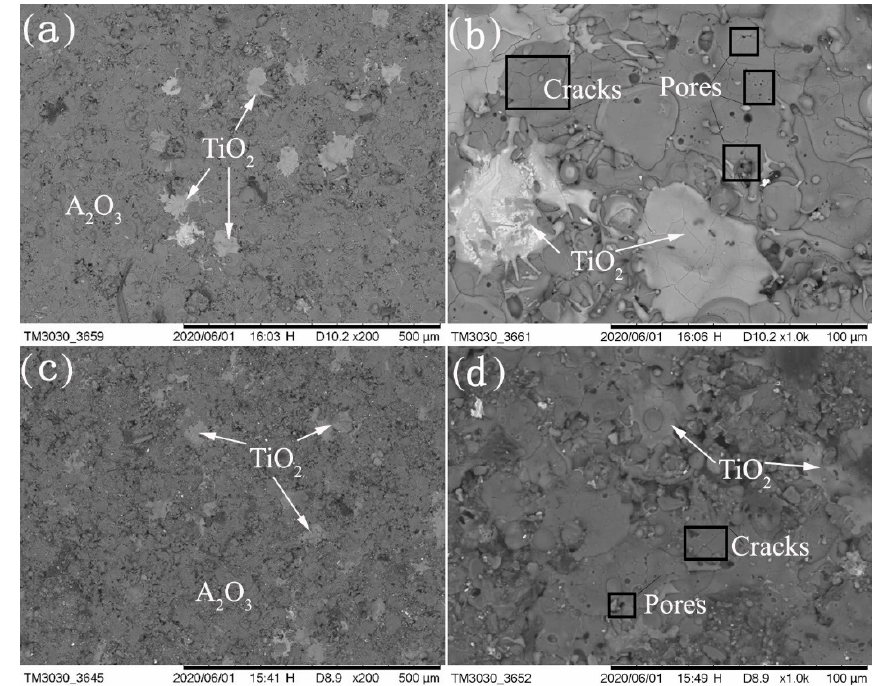
Figure 4. SEM morphologies of the AT13 coatings prepared at ( a , b ) nonoptimized parameters and ( c , d ) optimized parameters.